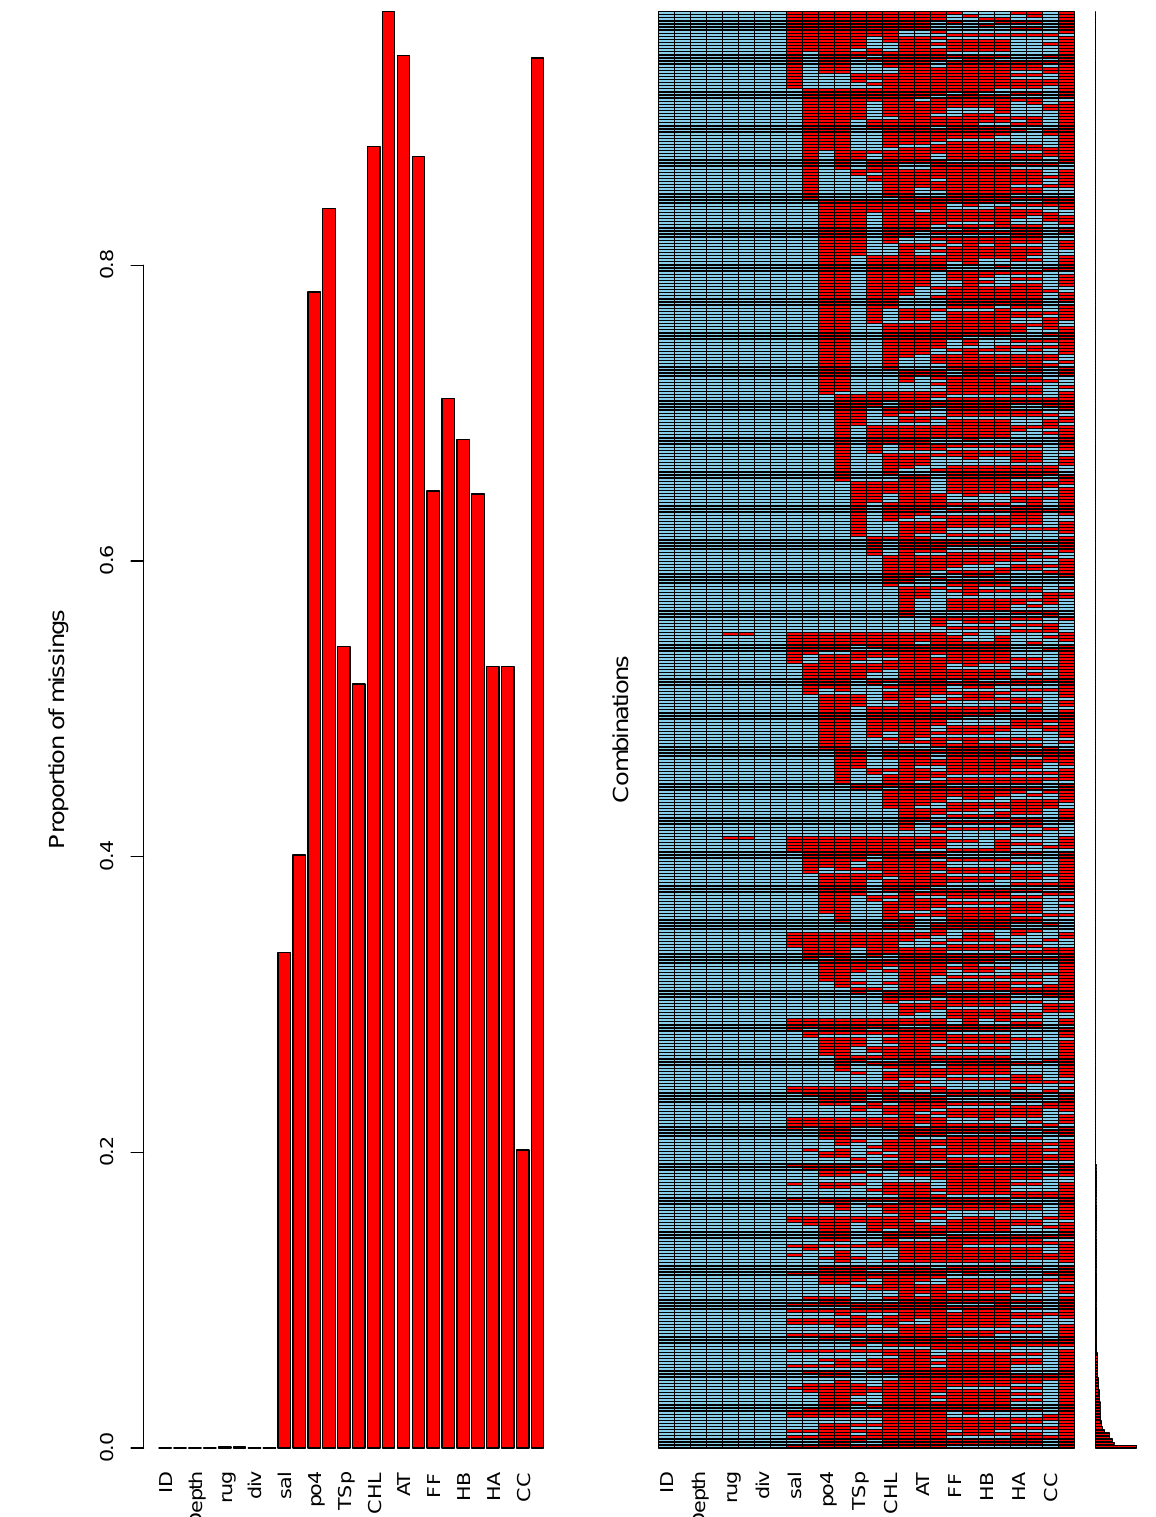
Figure 4. The graph of the missing data using the aggr function in the VIM R package [38]. The data were a reduced set based on including only cases with at least 14 observations out of a possible 26. The shortened variable names are linked in the data description